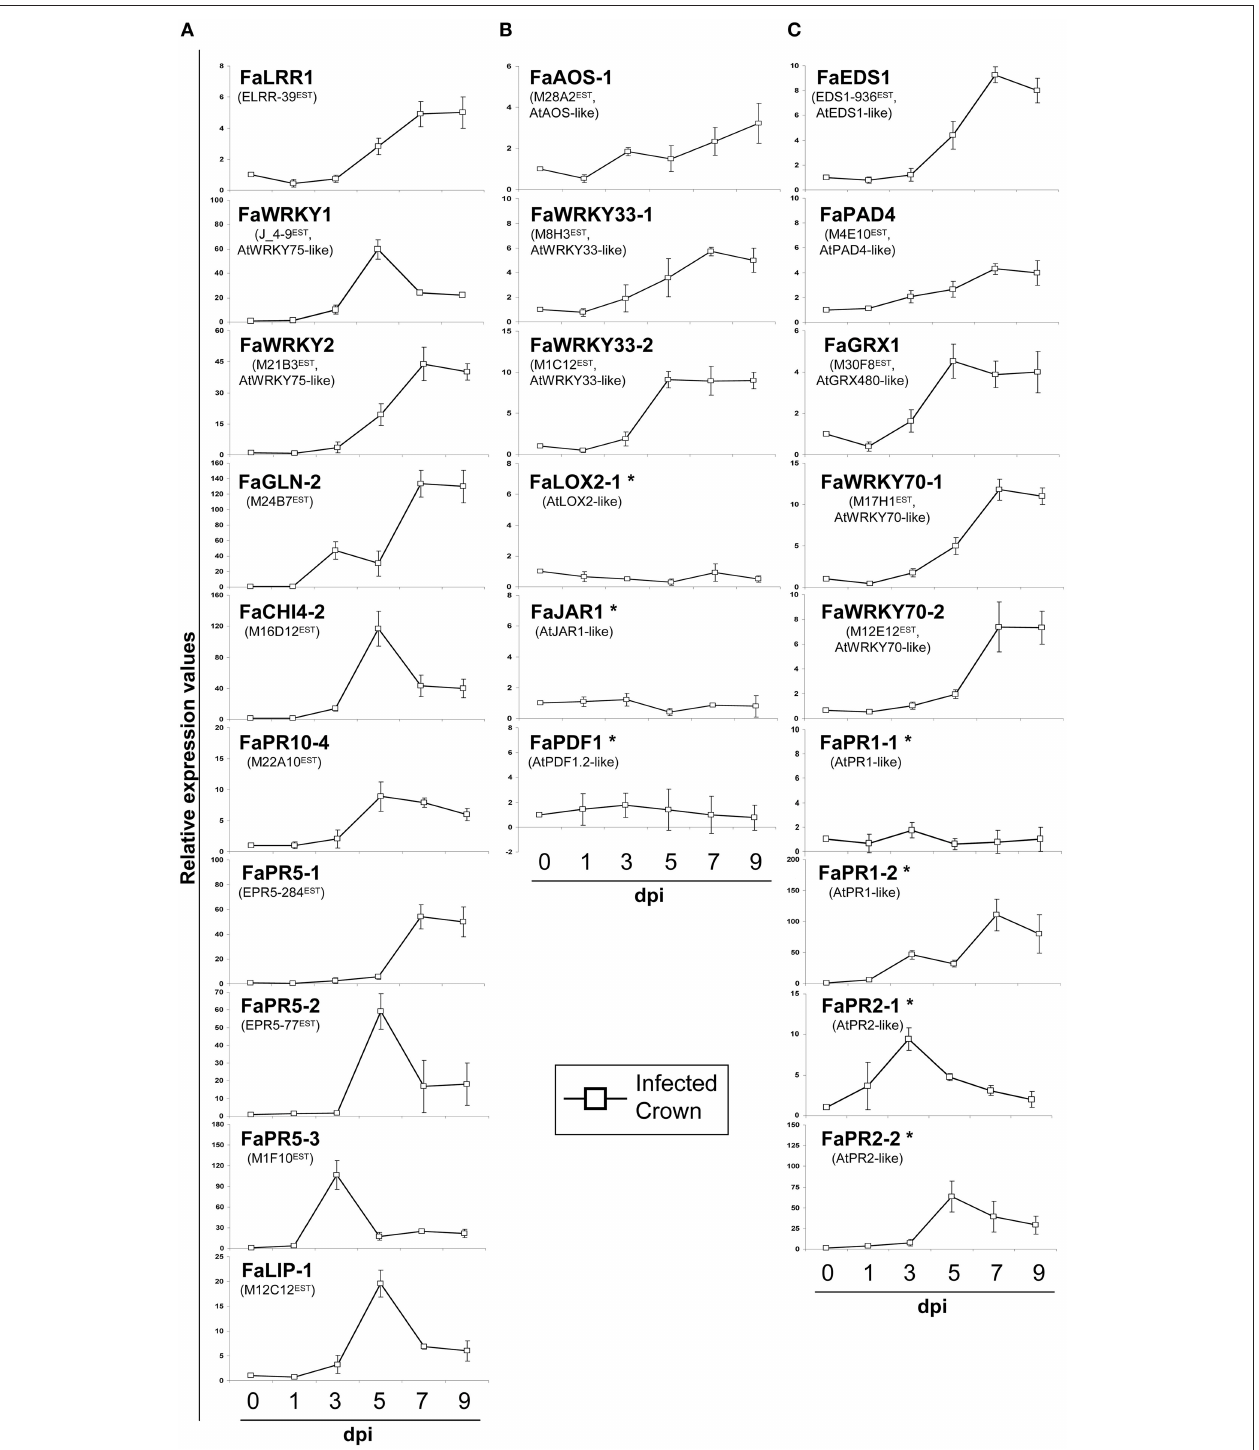
FIGURE 5 | Relative expression values by RTqPCR analysis of upregulated strawberry genes during C. acutatum infection. (A) Relevant strawberry genes in this study, (B) JA-responsive marker genes, and (C) SA-responsive marker genes. Strawberry crowns were harvested at different days post-treatment (dpi) either with mock or C. acutatum spore suspension. At each time point, every inoculated sample was compared with its corresponding mock treated sample. In the graphics, standard value 1 at T0 was added to better illustrate changes. Asterisk marks genes not present in the Array dataset. Arabidopsis orthologous genes are AT5G13080 ( AtWRKY75 ), AT5G42650 ( AtAOS ), AT2G38470 ( AtWRKY33 ), AT3G45140 ( AtLOX2 ), AT2G46370 ( AtJAR1 ), AT5G44420 ( AtPDF1.2 ), AT3G48090 ( AtEDS1 ), AT3G52430 ( AtPAD4 ), AT1G28480 ( AtGRX480 ), AT3G56400 ( AtWRKY70 ), AT2G14610 ( AtPR1 ), AT3G57260 ( AtPR2 ).